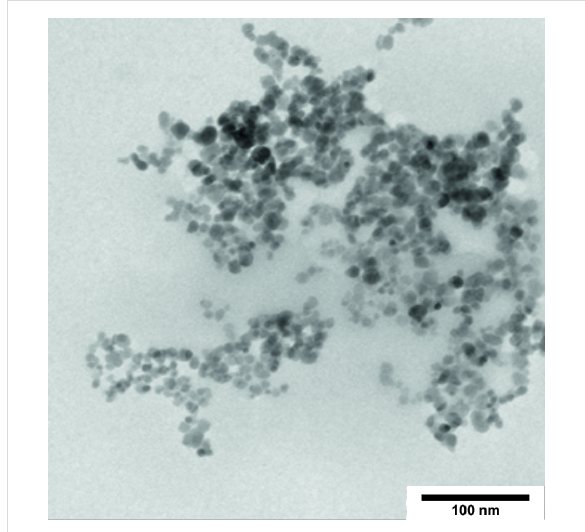
Figure 9: TEM micrograph of iron oxide nanoparticles prepared from an aqueous